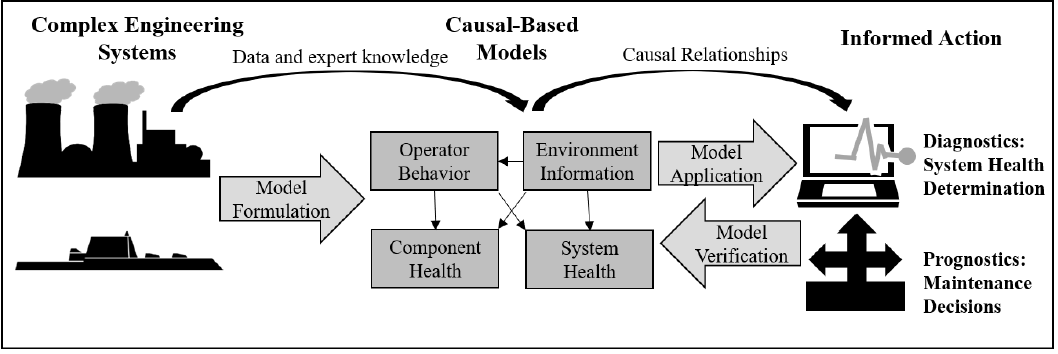
Figure 1. Modeling complex engineering systems (CESs), such as power plants and large maritime vessels, with causal-based models such as dynamic Bayesian networks, provides system operators and maintainers improved diagnostic and prognostic awareness. This causal knowledge about the system is particularly important following an accident event when action is needed to mitigate system damage and loss of